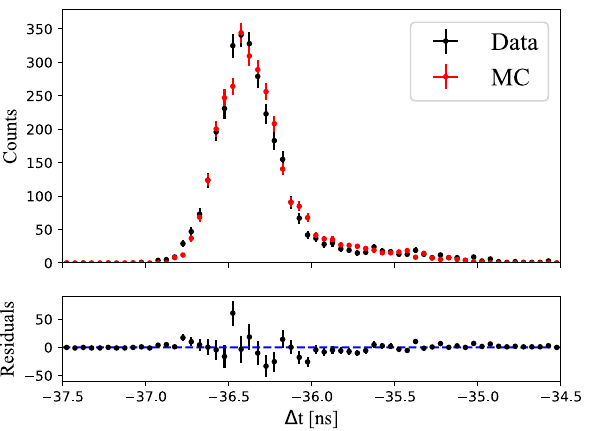
Fig. 8 The observed time profile of Cherenkov light in the 1% WbLS MC, before and after applying the trigger charge cut. The cut selects events that have high occupancy in the trigger PMT, which narrows and symmetrizes the trigger profile. The small tail at larger times is due to backscatters of PEs within the